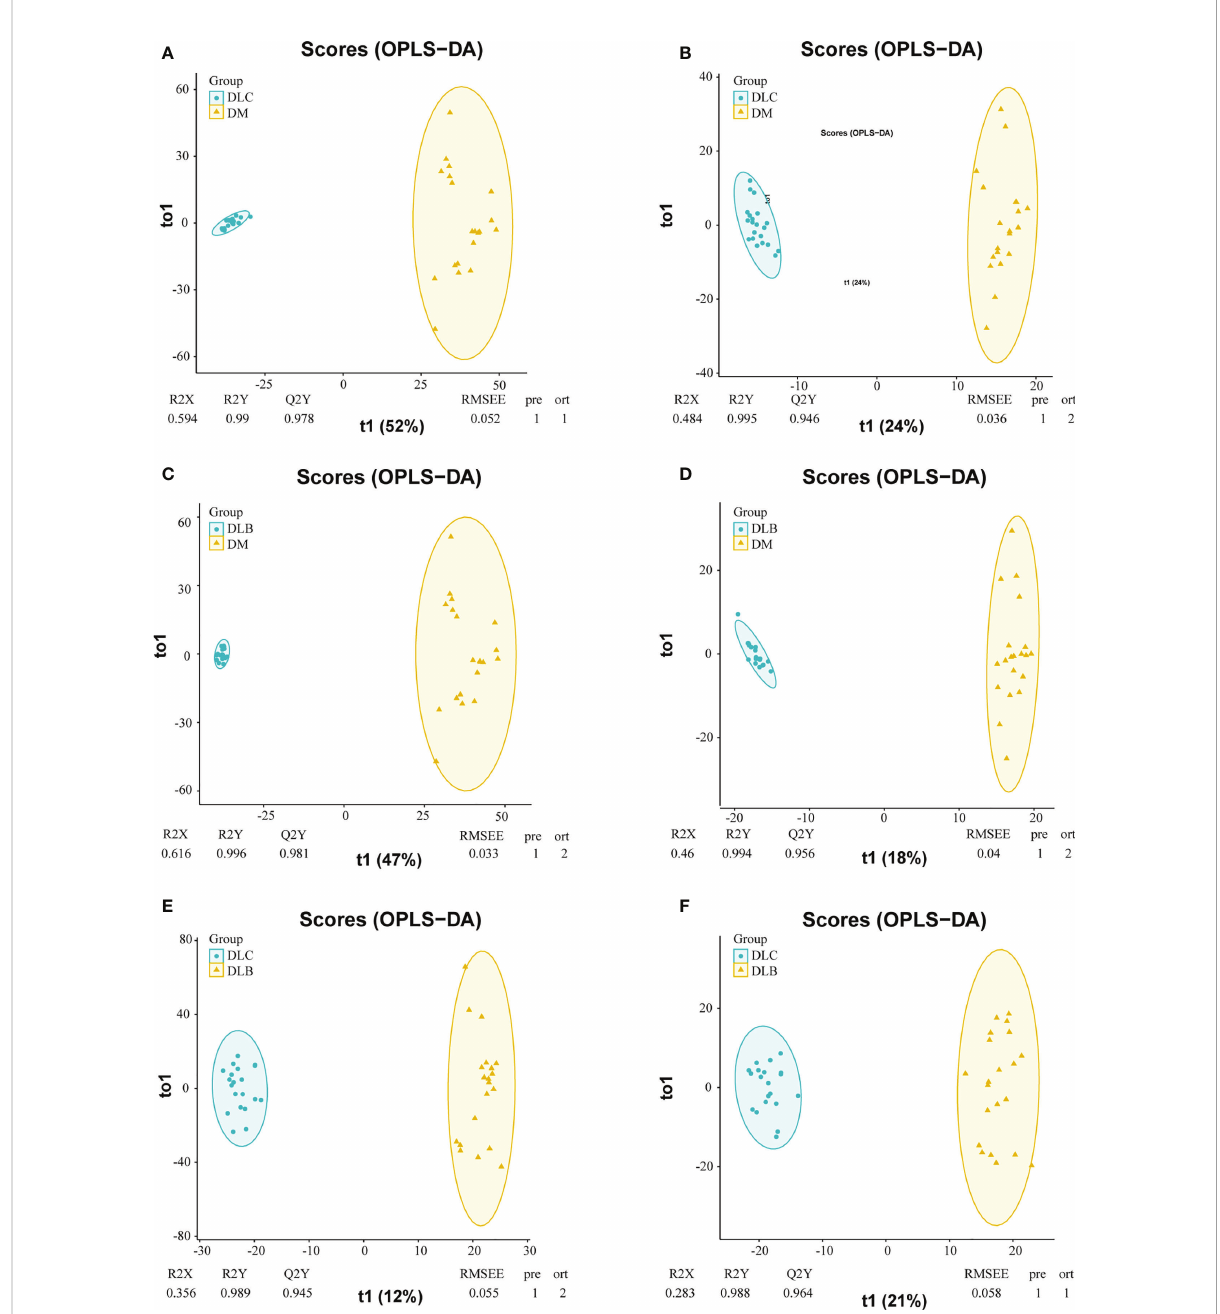
FIGURE 2 OPLS-DA plots of the metabolities detected in serums, DLC vs DM in positive mode (A) , DLC vs DM in negative mode (B) ; DLB in positive mode (C) DLB vs DM in negative mode (D) DLC vs DLB in positive mode (E) , DLC vs DLB in negative mode (F)